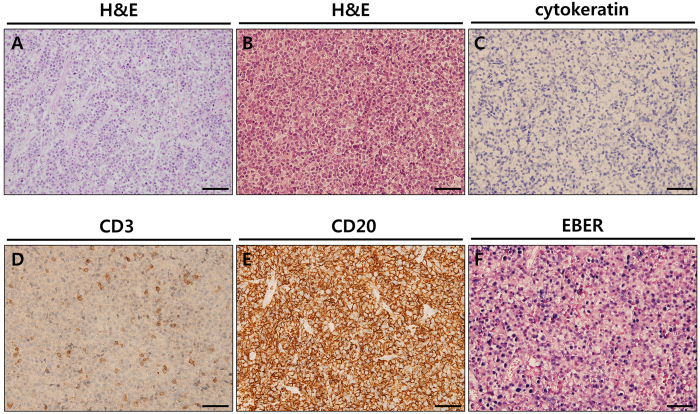
Representative histology of lymphoma transformed PDX tumours.(A) F0 tumour section slides were stained by H & E. (B) F1 tumour section slides were stained by H & E. (C) Cytokeratin, as a marker of epithelial tumour cells, was not detected by immunohistochemistry in F1 tumour. (D) CD3, as a marker of T cells, was infrequently detected by immunohistochemistry in F1 tumour. (E) CD20, as a marker of B cells, was detected by immunohistochemistry in F1 tumour. (F) Epstein-Barr encoded RNA was detected by in situ hybridization in F1 tumour. Scale bars = 50 μm.